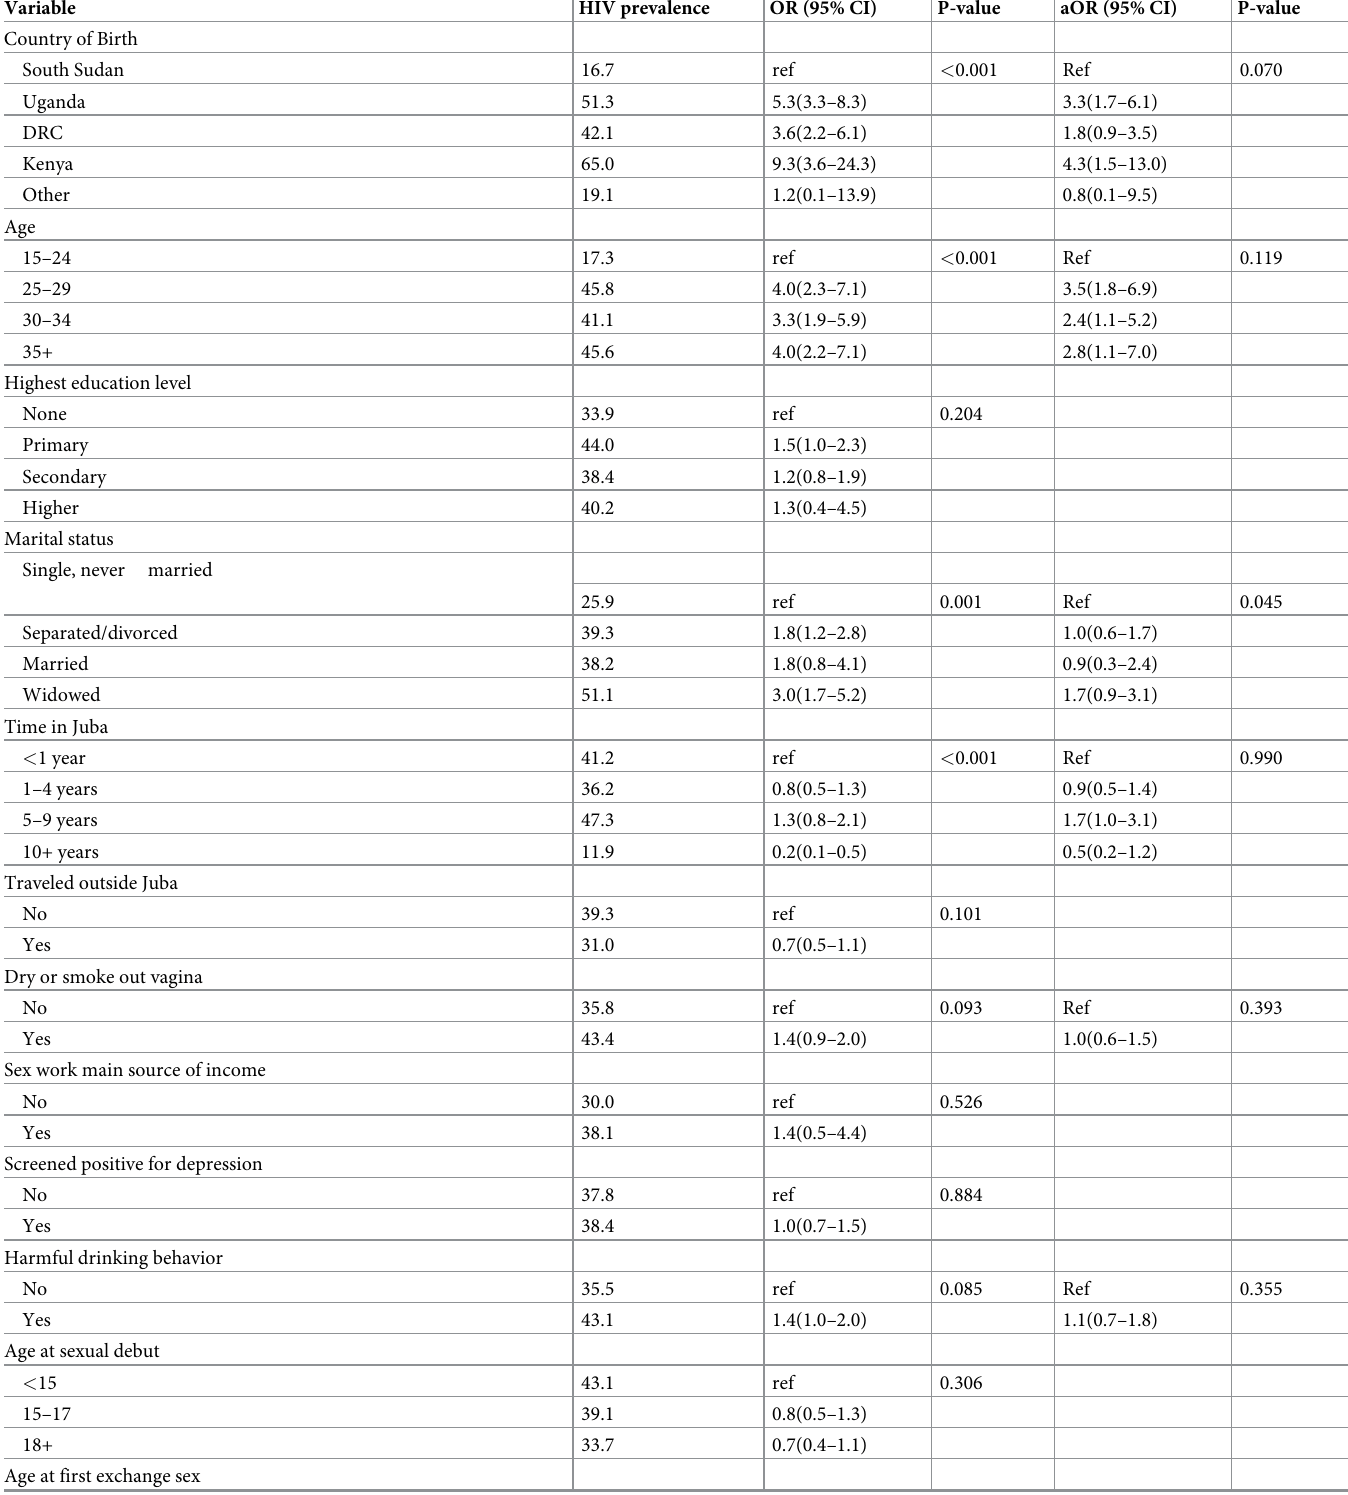
Table 4. Bivariate and multivariate model for HIV infection among FSW in Juba, 2015–2016 (N =